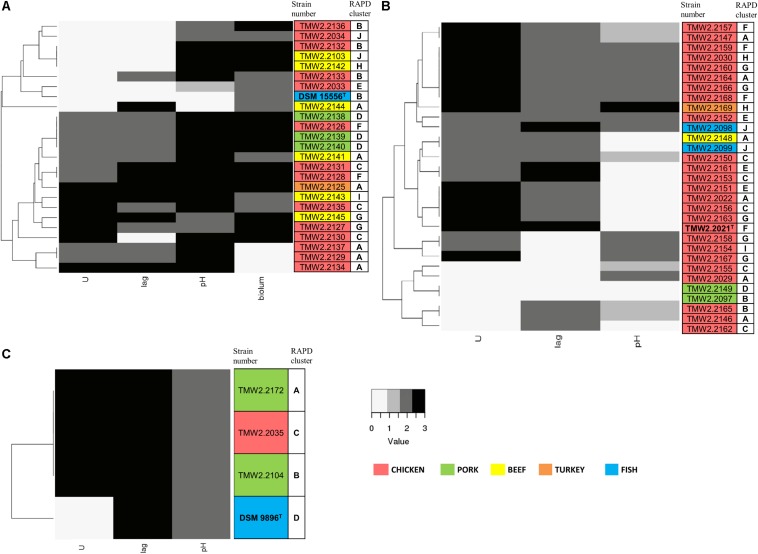
Clustering of the strains by their growth rate (U), lag phase (lag), influence on pH, and bioluminescence (biolum, if existing). Growth rate and lag phase were determined in meat simulation medium at 4°C. Mean values were statistically grouped as low/medium/high and scored from 0 to 3. The highest score was given to the highest growth rates and lowest lag phases, respectively, and a score of 2 was given to medium values. The pH was measured when the cultures reached their highest OD600 and scored as follows: 0 – pH ≤5.7, 1 – pH 5.7–5.9, 2 – pH 5.9–6.8, 3 – pH >6.8. Bioluminescence of P. phosphoreum was evaluated manually on agar plates. The highest score was given to the strongest bioluminescence. The different isolation sources are displayed in colors and type strains are marked with bolt letters. (A)
P. phosphoreum, type strain DSM 15556T, (B)
P. carnosum, type strain TMW2.2021, (C)
P. iliopiscarium, type strain DSM 9896T.